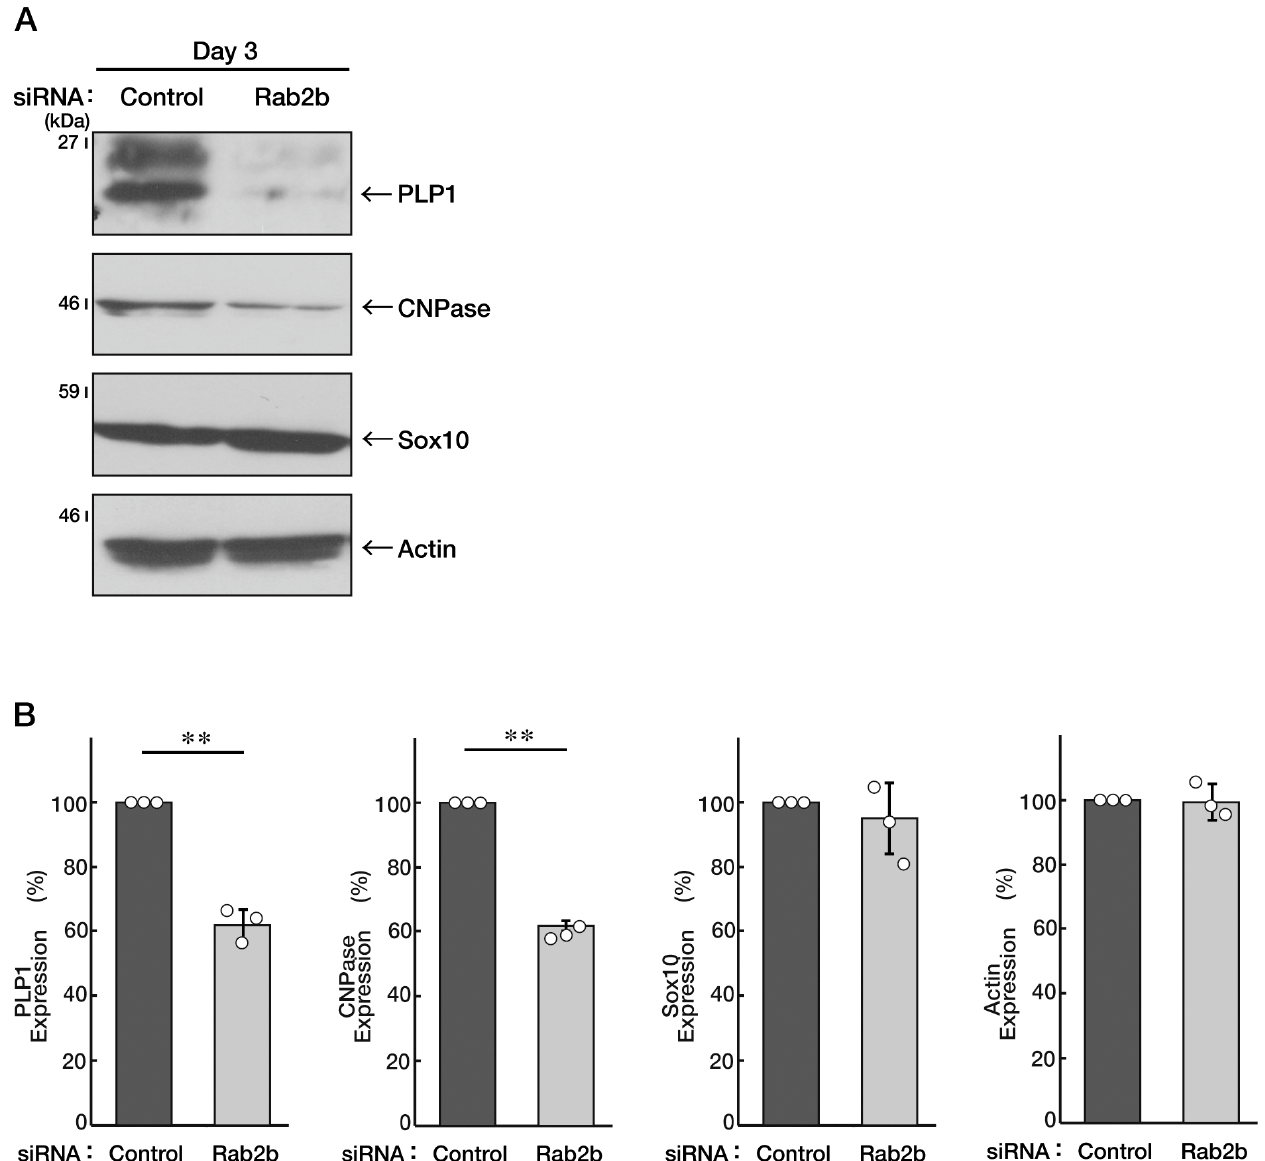
Figure 8. Knockdown of Rab2b decreases expression levels of marker proteins in FBD-102b cells. ( A , B ) FBD-102b cells were transfected with a control or Rab2b siRNAs. Transfected cells were allowed to be cultured for 3 days following the induction of differentiation. Each cell lysate was collected for an immunoblotting for an antibody against PLP1, CNPase, Sox10, or actin. Immunoreactive bands were quantitatively calculated compared to the respective controls (100%) and statistically depicted as graphs (** p < 0.01; n = 3 blots). White circles show percentages in the respective independent experiments.